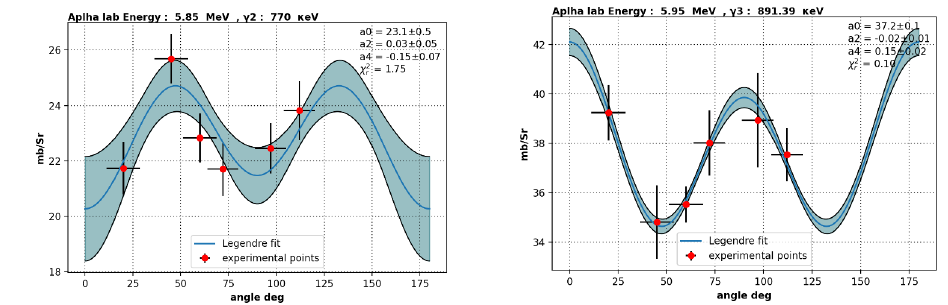
Figure 4. Gamma ray angular distributions from gamma rays originating from 37 Cl( α ,n 2 γ ) 40 K and 37 Cl( α ,n 40 K reaction 3 γ )